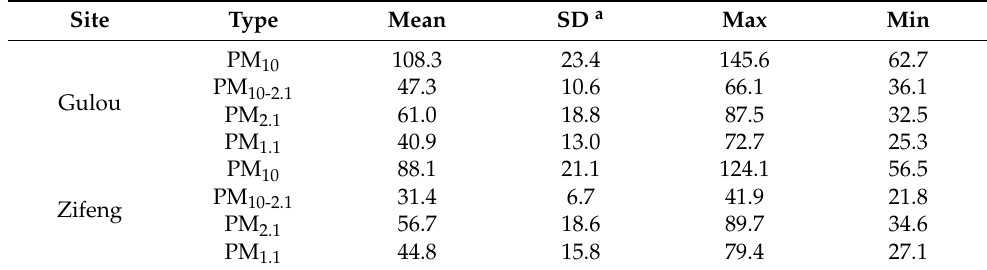
Table 1. Statistics of measured PM 10 , PM 10-2.1 , PM 2.1 , and PM 1.1 at Gulou and Zifeng ( µ g m -3